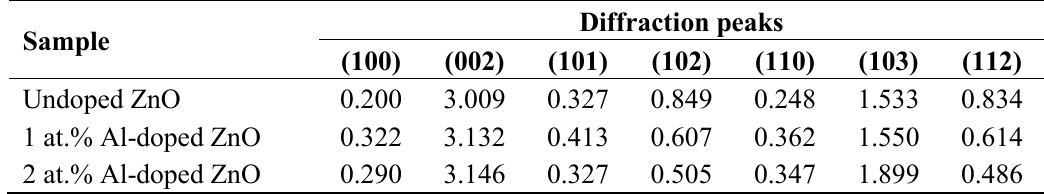
Table 1. Calculated Texture Coefficients of 7-layer ZnO thin films for the 7 main peaks.